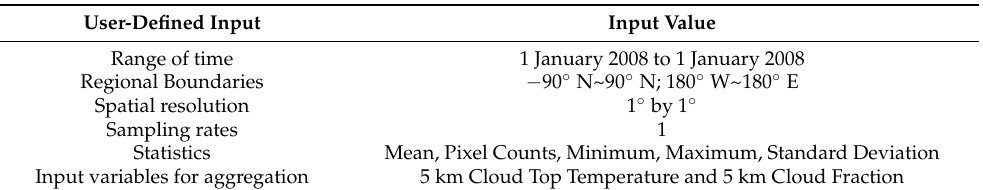
Table 2. The inputs that are defined for the direct comparison with MYD08_D3 product on 1 January